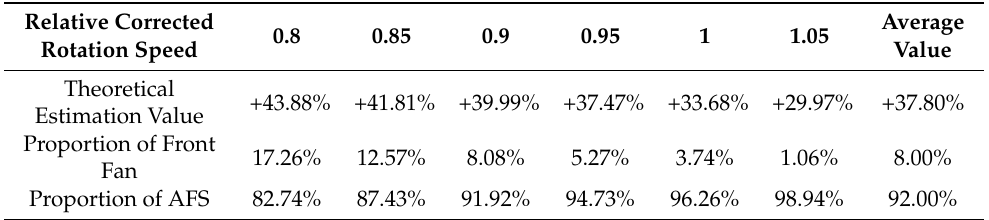
Table 7. The Theoretical Estimation Percentages of Flow Rate Adjustment with the Consideration of both Front Fan and